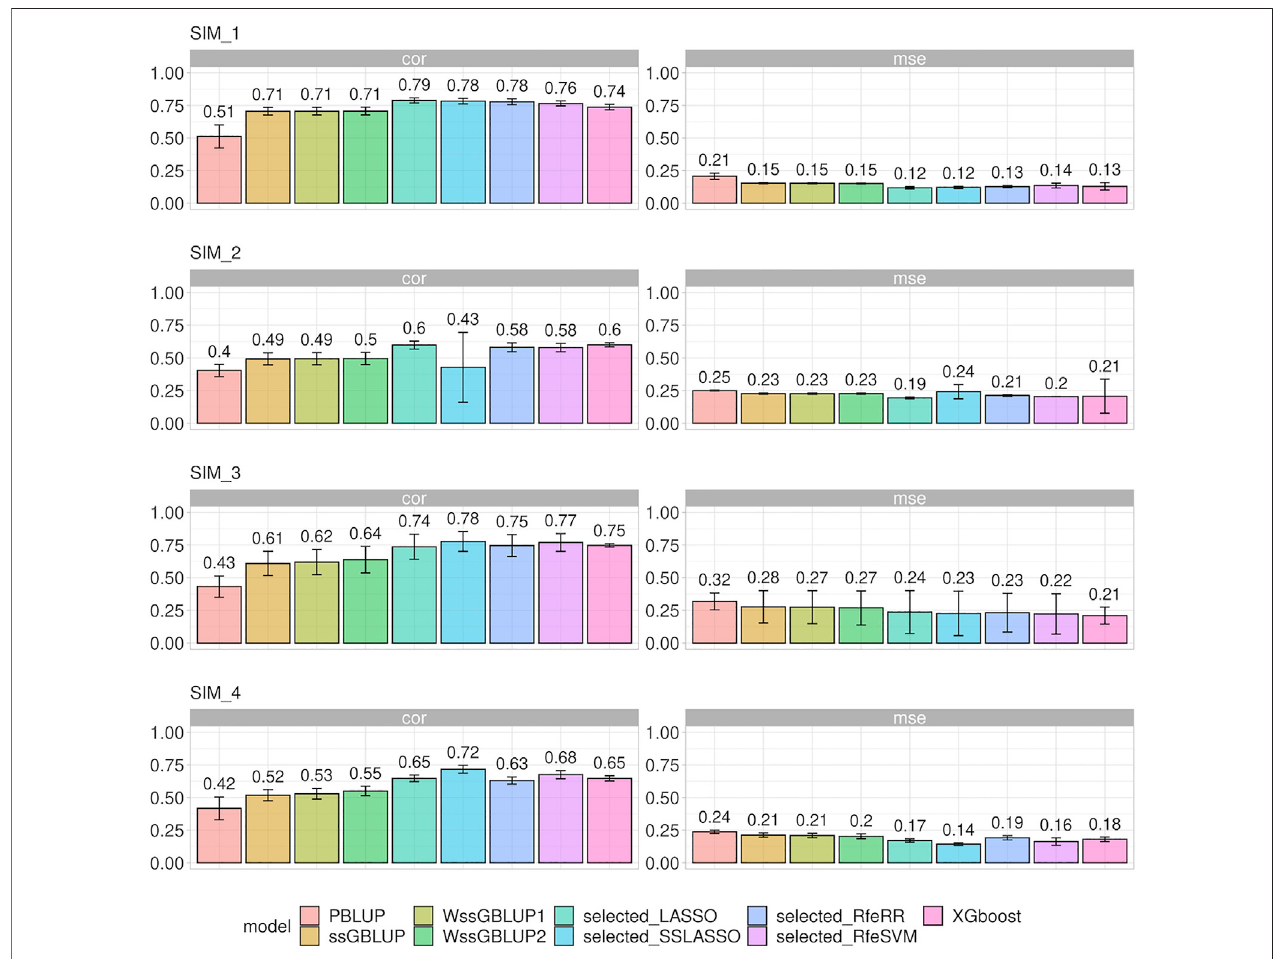
FIGURE 6 | Bar plot representing correlation (corr) and mean squared error (MSE) between predicted and true breeding values on the four different simulated populations. Error bars represent standard deviations.